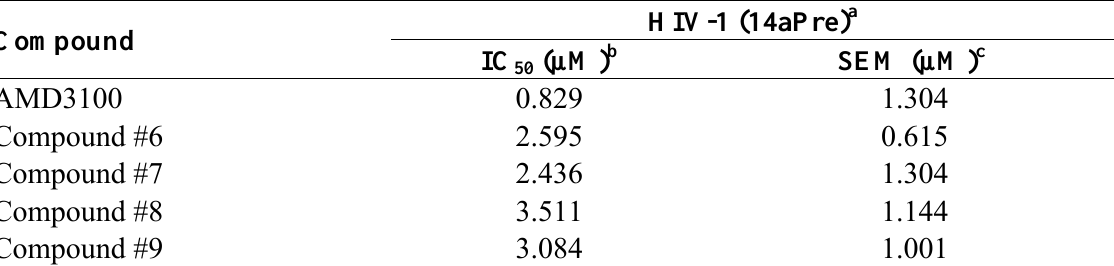
Table 1. 14aPre phenotypic susceptibility.